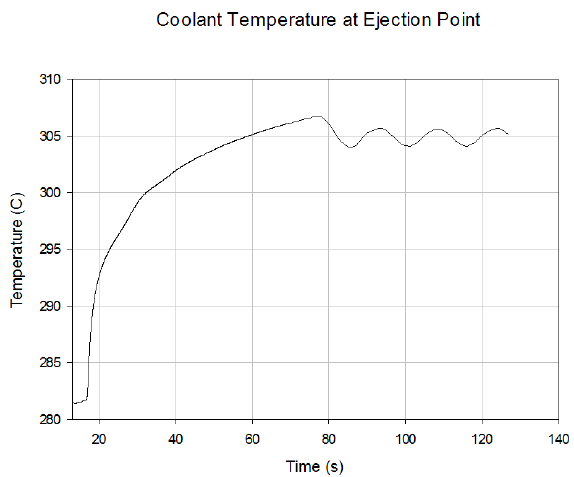
Figure 21. Coolant density at ejection point.